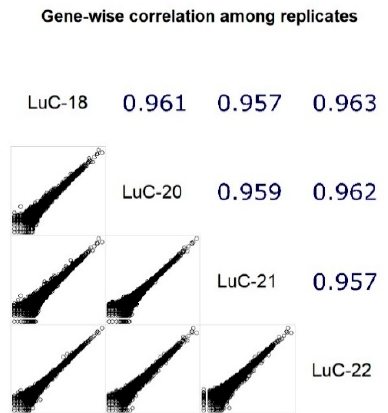
Figure 3. Correlation plot for four technical replicates (different slices from the same FFPE block) obtained from lung cancer tissue specimen. The samples were sequenced and processed separately. Top diagonal shows correlation coefficients (Spearman’s rho). Bottom diagonal shows pairwise plots for gene expression values.